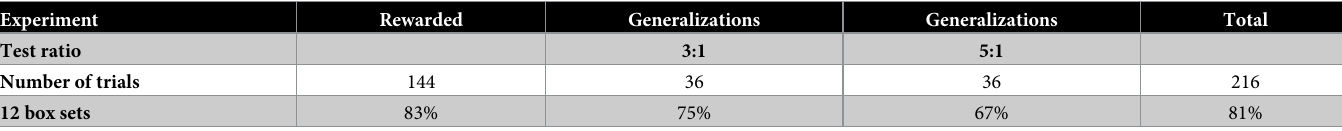
Table 4. Testing sessions including generalization trials of in-between ratios of acetoin:octenol reflecting non-infected individuals.